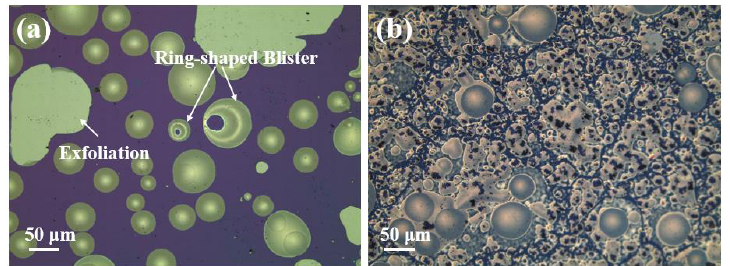
Figure 3. The surface morphology of blisters and craters in Samples C ( a ) and D ( b ) after 300 °C annealing for 1 h.